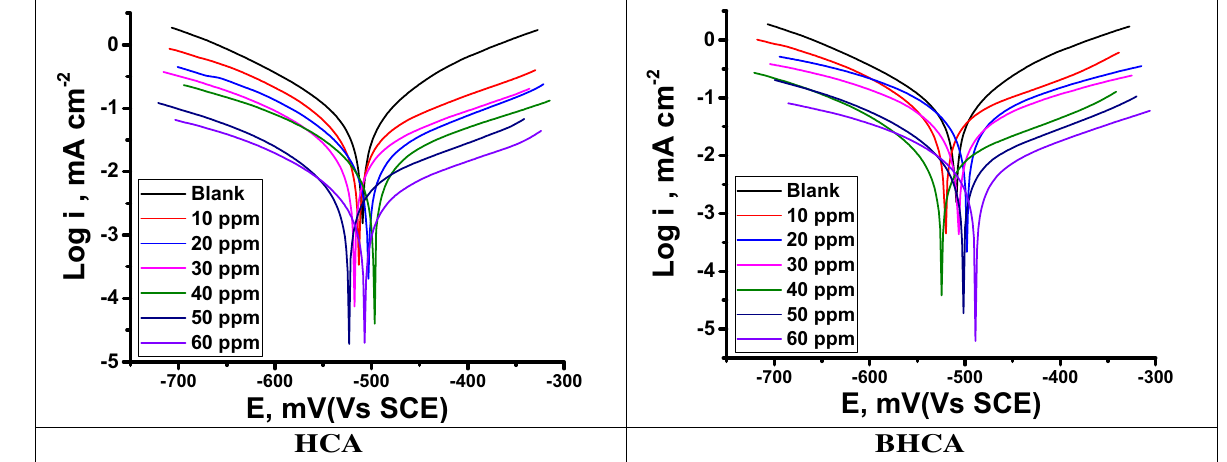
Figure 7. PDP bends for the dissolution of CS in 1 M HCl with and without altered doses of HCA &BHCA at 298 K.